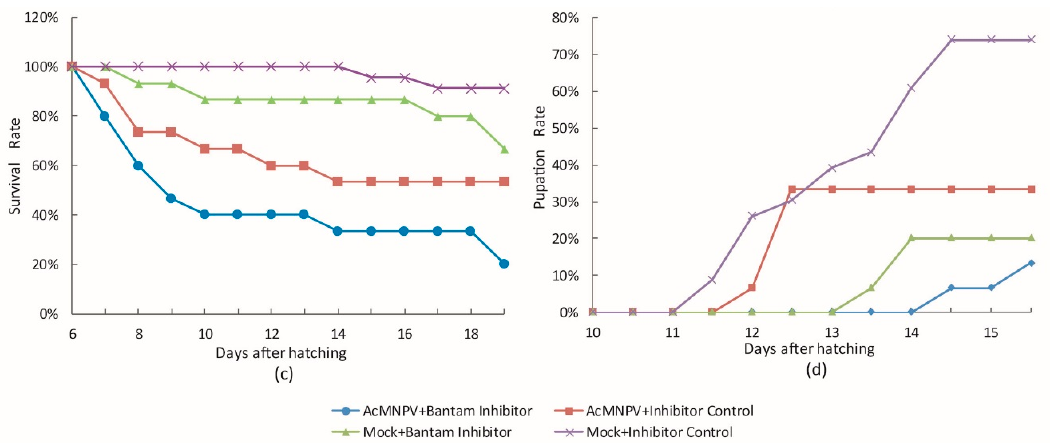
Figure 5. The effect of bantam -antagomiR on AcMNPV infection in larvae. Second instar larvae of S. litura ( a , b ) and S. exigua ( c , d ) were administrated with bantam -antagomiR or control on a daily basis. They were then inoculated with AcMNPV polyhedra per os , or mock infected twice, on Day 2 and 4 after first antagomirR administration. Larval death ( a , c ) and pupation ( b , d ) were recorded. Each group includes 15 or more larvae.